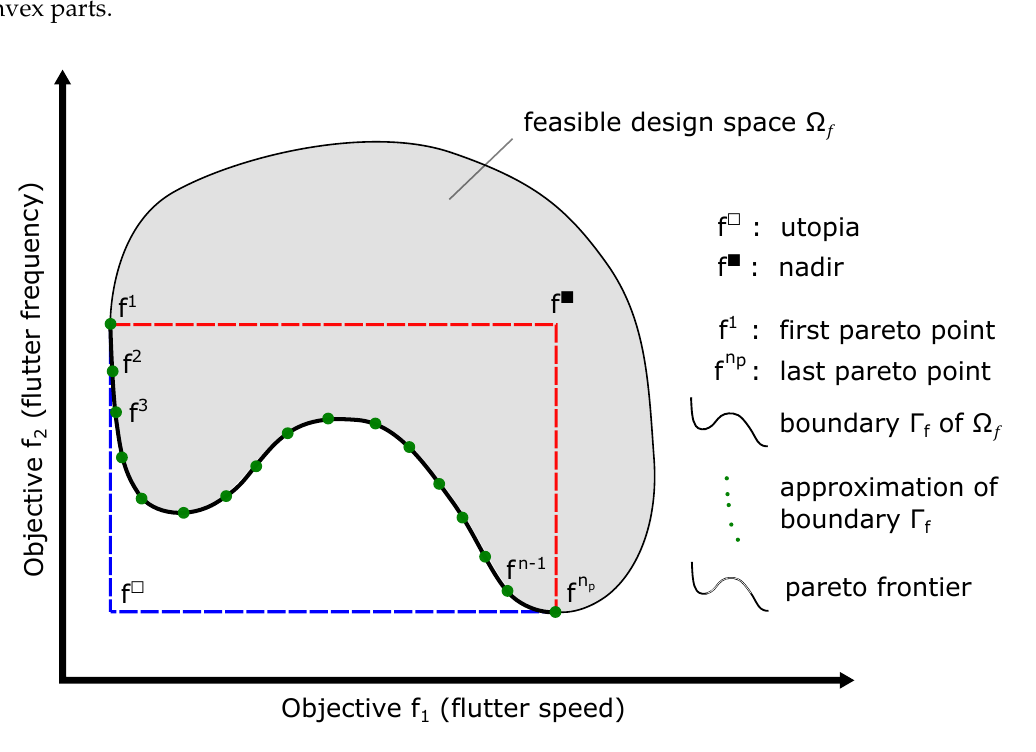
Figure 4. Exemplary design space and Pareto frontier